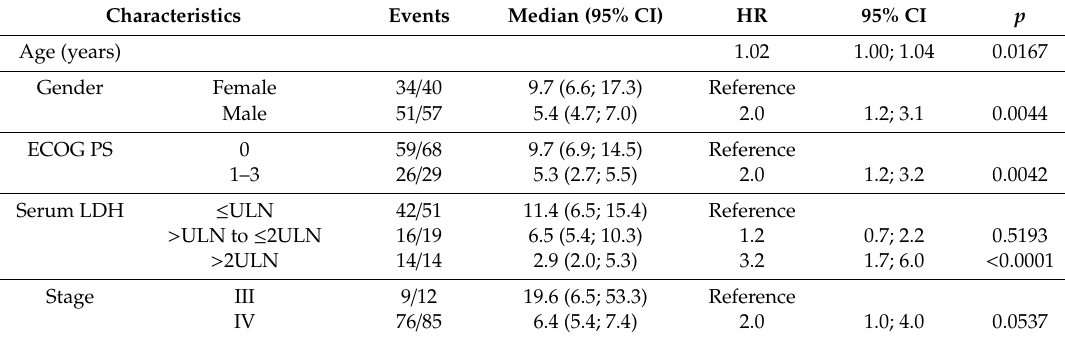
Table 2. Univariate Cox proportional hazards models of progression free survival. CI—confidence interval; HR—hazard ratio; NE—not